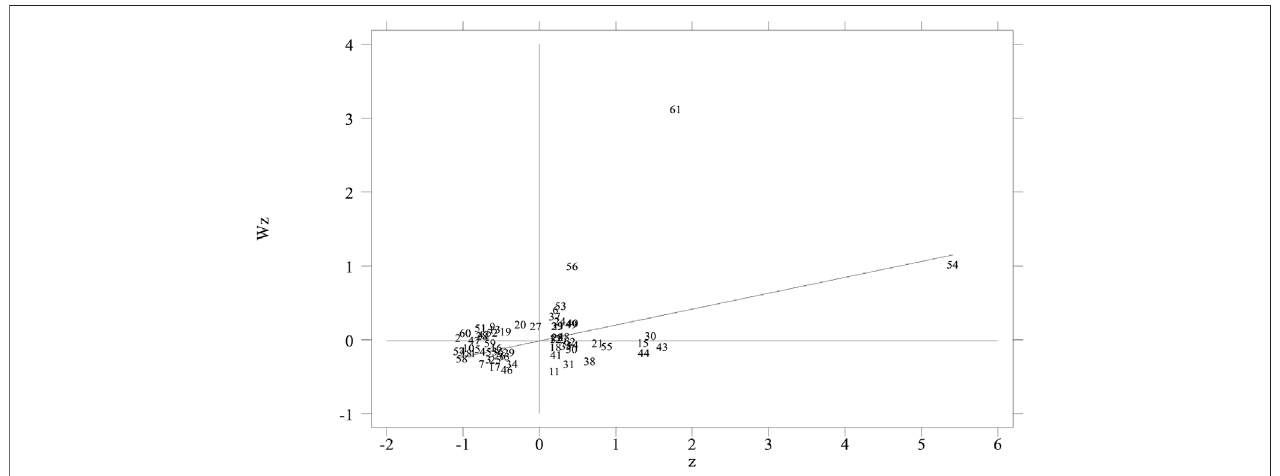
FIGURE 7 | Moran scatter plot of eco-ef fi ciency in